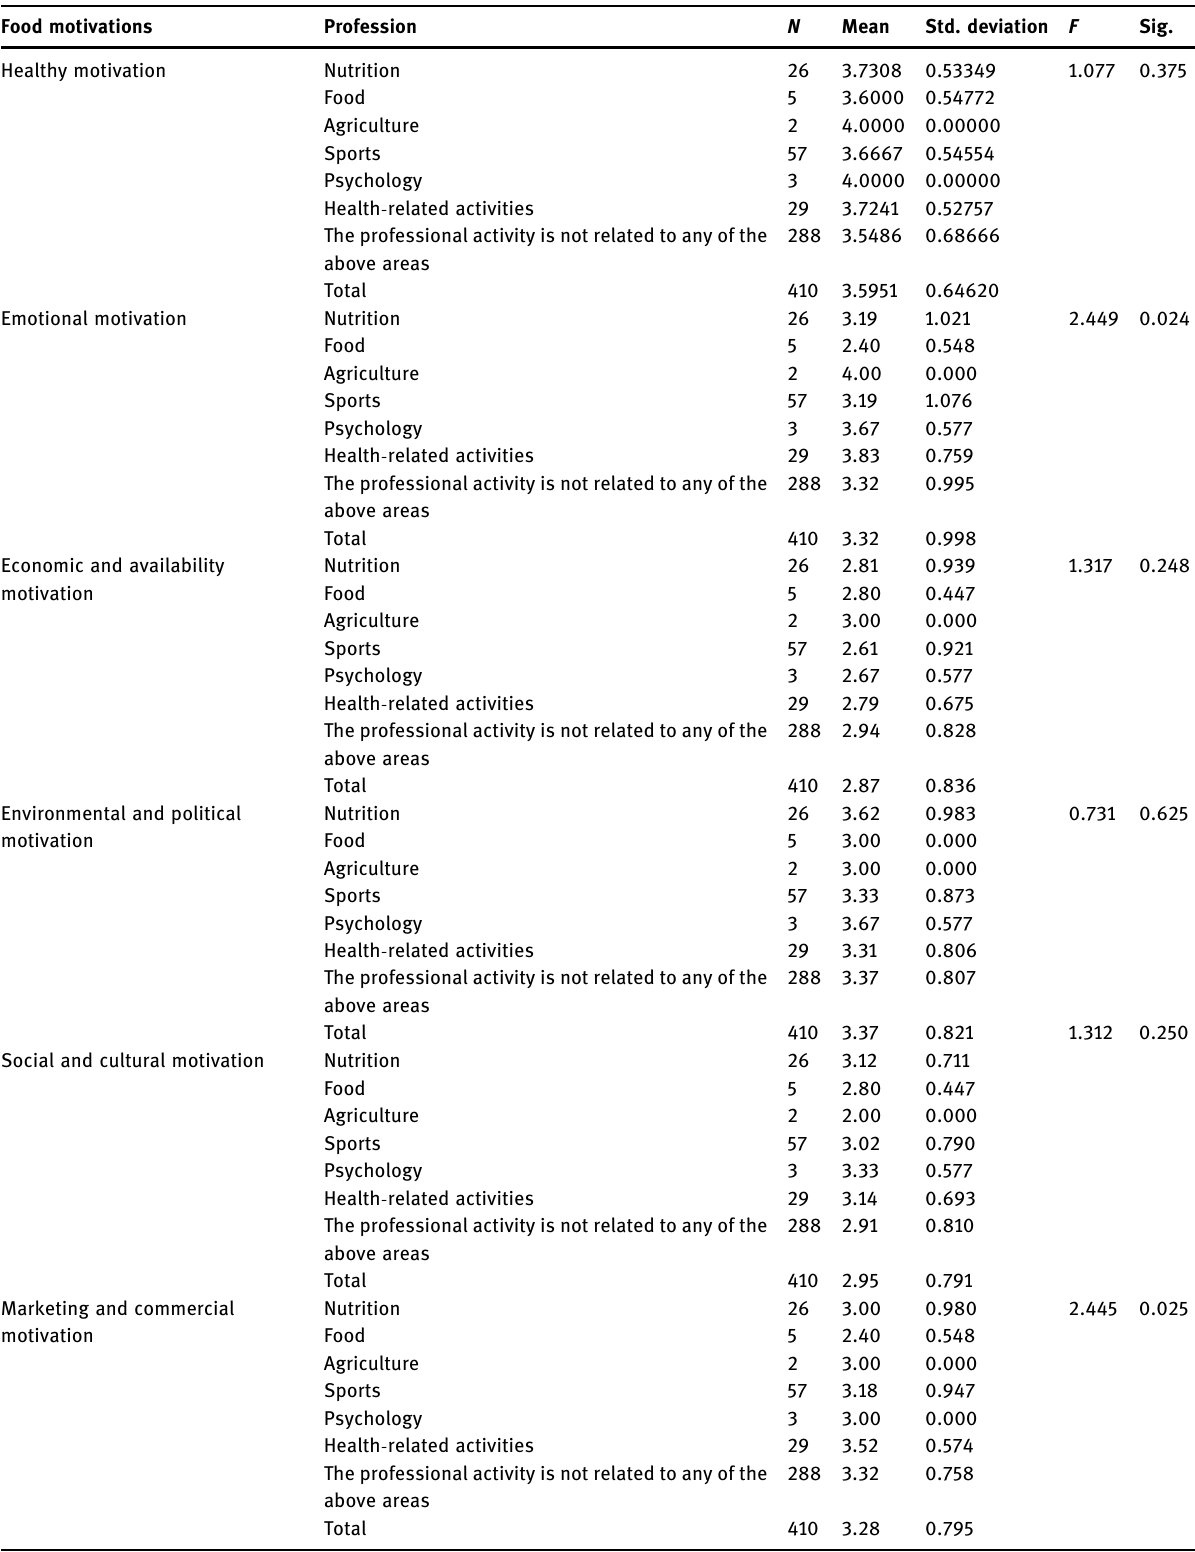
Table 8: ANOVA and mean results of fi eld of work and food motivation factors Food motivations Mean Std. deviation F